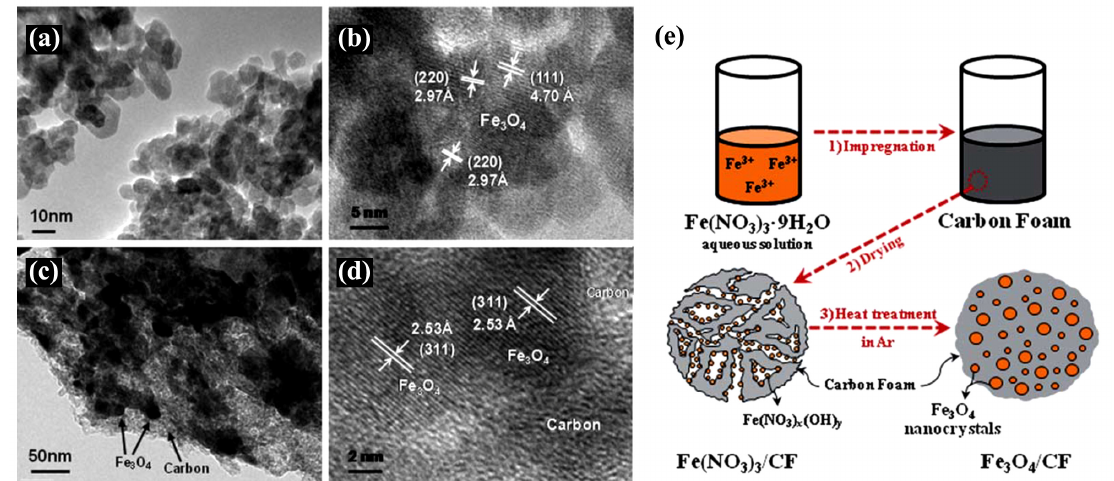
Figure 28. TEM images for unsupported Fe method; ( c , d ) the in situ formation of Fe representation of the in situ formation of Fe foam. Reprinted with permission from [52]. Copyright 2011 Royal Society of